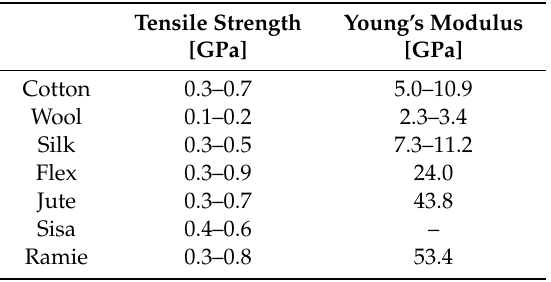
Figure 1. Cellulose contained in plants or trees has a hierarchical structure from the meter to the nanometer scale, as shown in ( a ). A schematic diagram of the reaction between cellulose and strong acid to obtain Nanocellulose is shown in ( b ). Bionanocellulose cultured from cellulose-synthesizing bacteria is shown in ( c ). Figure 1 was drawn by co-author R. Hamano. Table 1. Comparison of mechanical properties of natural fibers [31].